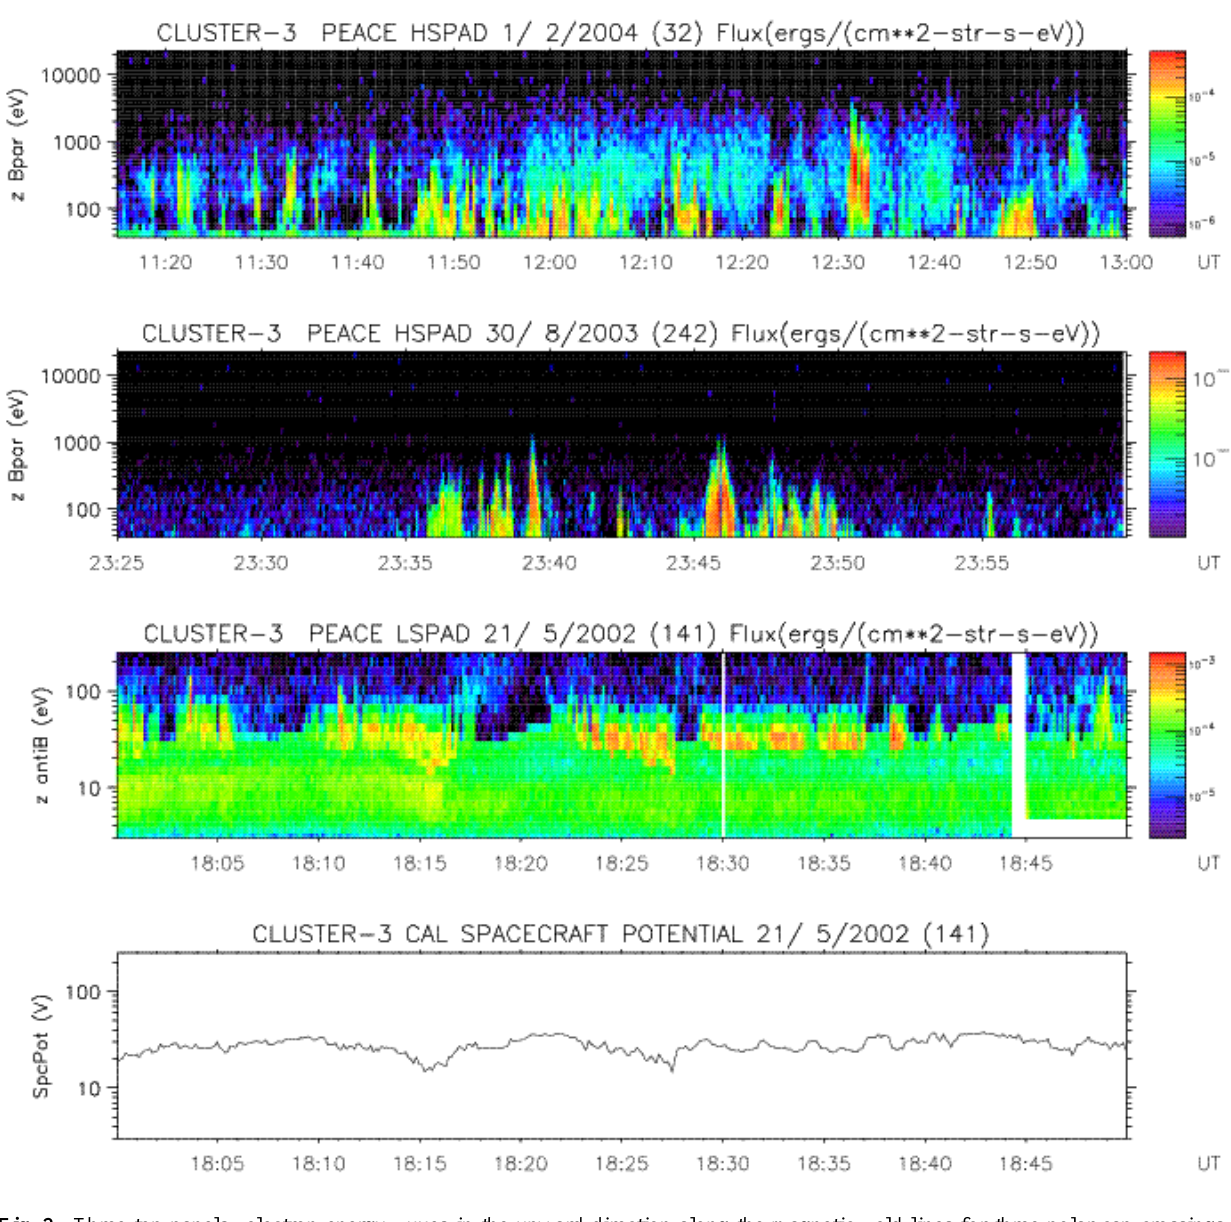
Fig. 2. Three top panels: electron energy fluxes in the upward direction along the magnetic field lines for three polar cap crossings: 1 February 2004 (top panel), 30 August 2003 (second panel) and 21 May 2002 (third panel). Bottom panel: spacecraft potential for 21 May 2002 in the same format as panel